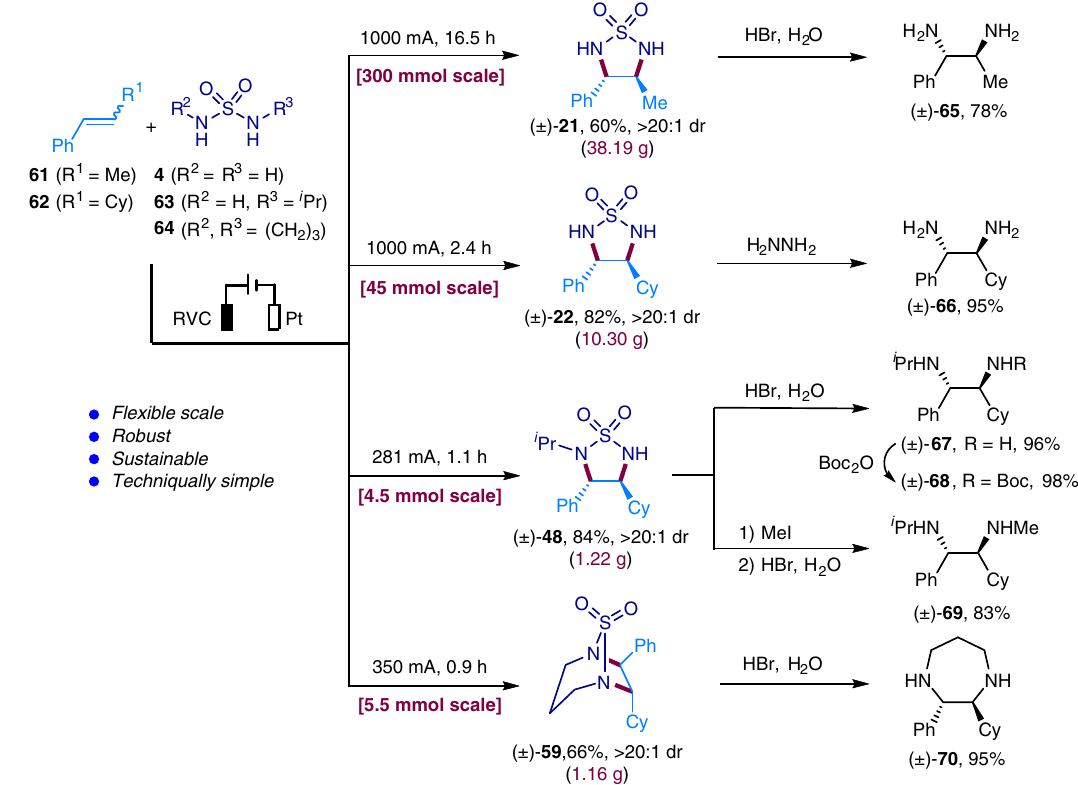
Fig. 3 Gram scale synthesis and further product transformations. Gram scale synthesis of compounds 21 , 22 , 48 , and 59 , and their conversion to